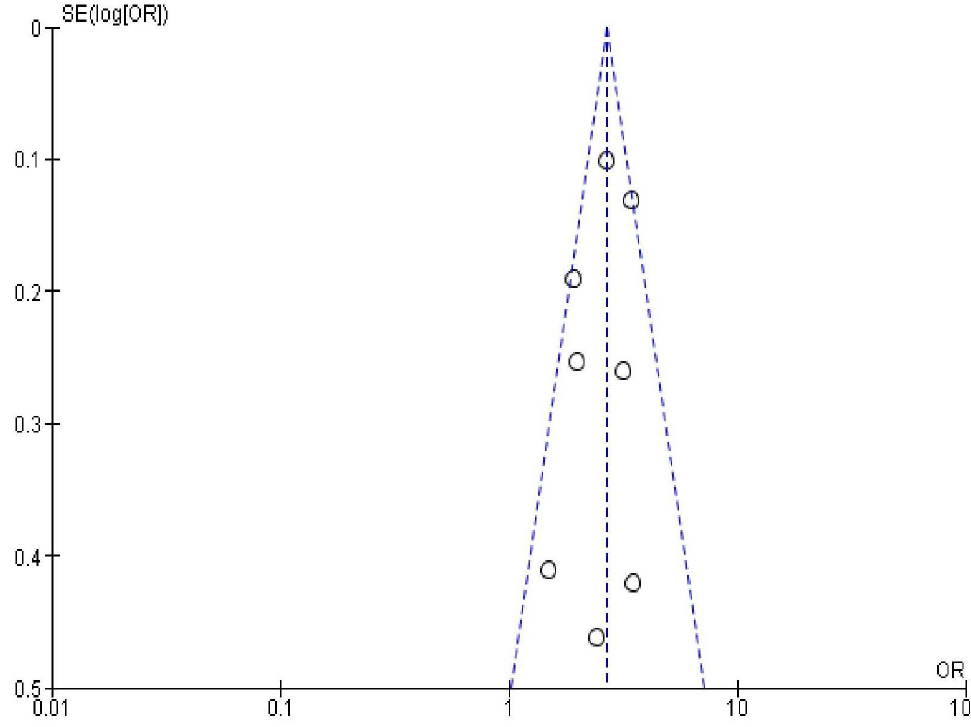
Fig 13. Publication bias on women’s educational